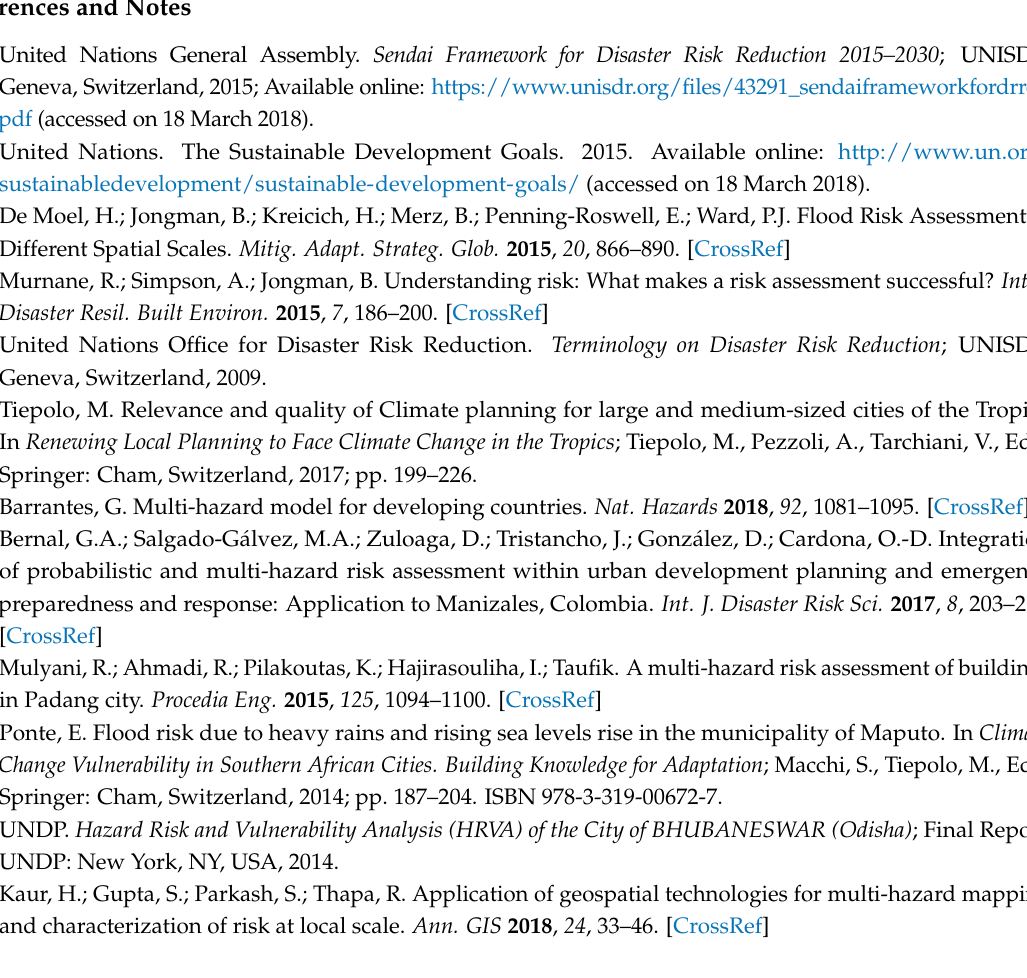
Table S1: Equations, Table S2: SPI 1981–2017 for the municipalities of the Dosso region (Niger), Table S3: Disaster frequency in the Dosso region (Niger) according municipality and settlement,